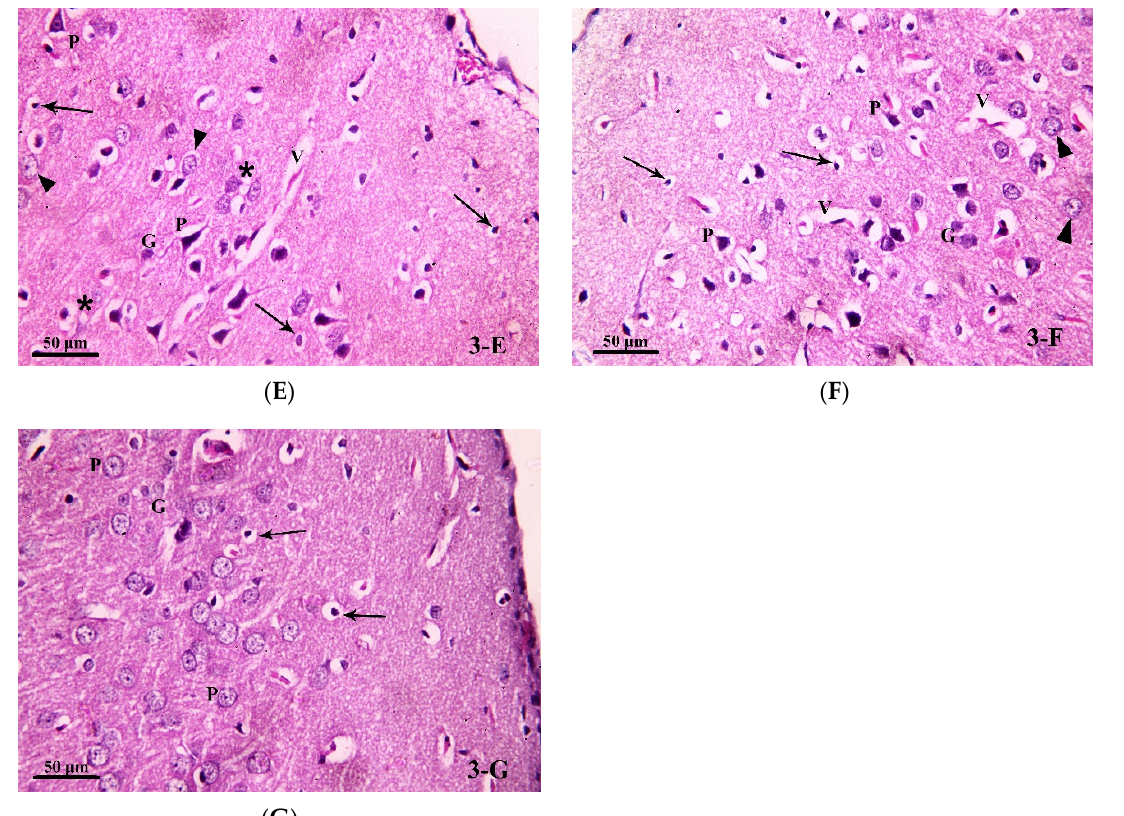
Figure 3. Photomicrograph of brain tissue (H& E stain) from ( A , B ) Group I, showing the six layers of the cerebral cortex in the control group (H&E × 100). The nerve cells (pyramidal (P) and granule (G)) in the different layers of the cerebral cortex with large, rounded nuclei and prominent nucleoli. Nerve cells are separated by homogenous neuropil, containing small, deeply stained nuclei—most probably glial cells—( ↑ ) (H&E × 400). ( C , D ) Group II showed distorted layers of the cerebral cortex in the alcoholic group. An area of aggregated mononuclear inflammatory cells (granuloma) can be seen ( ▲ ) (H&E × 100). Most of the pyramidal cells (P) and granule cells (G) in the different layers seen are shrunken, condensed, deeply stained and surrounded by a hallow. Small, deeply stained nuclei—most probably glial cells—are also surrounded by hallows ( ↑ ). Notice the pale, vacuolated neuropil (*) and the dilated blood vessel (V) (H&E × 400). ( E ) Group III, some pyramidal cells (P) and granule cells (G) are seen shrunken, condensed, deeply stained and surrounded by hallows. Notice some nerve cells have large, rounded nuclei and prominent nucleoli ( ▲ ). Small, deeply stained nuclei—most probably glial cells—are also surrounded by hallows ( ↑ ). The neuropil is pale and vacuolated (*). A dilated blood vessel (V) is seen (H&E × 400). ( F ) Group IV showed distorted layers of the cerebral cortex in group IV. Many pyramidal cells (P) and granule cells (G) are seen shrunken, condensed, deeply stained and surrounded by hallows. Notice few nerve cells have large, rounded nuclei and prominent nucleoli ( ▲ ). Small, deeply stained nuclei—most probably glial cells—are also surrounded by hallows ( ↑ ). Dilated blood vessels (V) are seen (H&E × 400). ( G ) Group V showed a more regular arrangement of layers of the cerebral cortex in group V. Most of the pyramidal(P) and granule (G) cells have large, rounded nuclei. Some nuclei have prominent nucleoli and others are vacuolated ( ∆ ). Some small, deeply stained nuclei—most probably glial cells—are surrounded by hallows ( ↑ ) (H&E × 400).